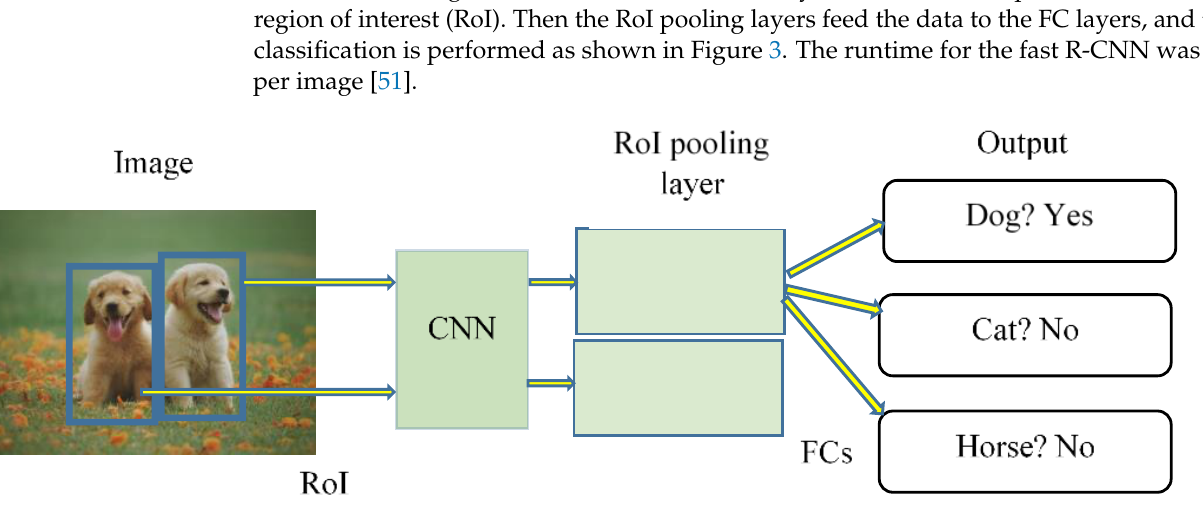
Figure 2. R-CNN architecture where CNNs are computed only for proposed regions.